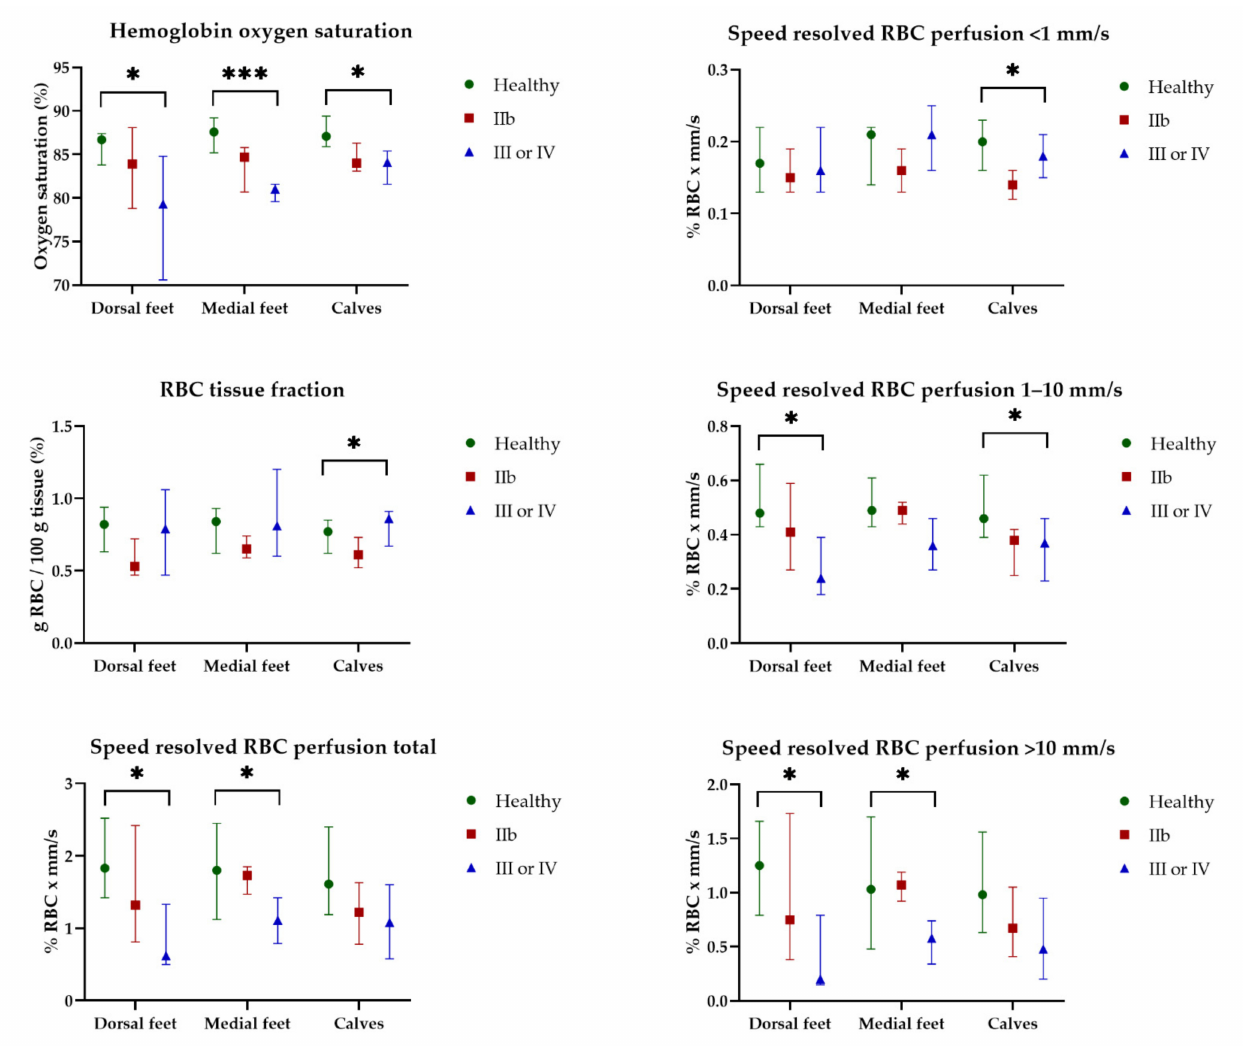
Figure 6. Continuous enhanced perfusion and oxygen saturation (EPOS) variables at 44 ◦ C between healthy volunteers (Healthy), patients with Fontaine class IIb (IIb), and patients with Fontaine class III or IV (III or IV) measured on the dorsal side of the foot, medial side of the foot, and the lateral side of the calf. Data are presented as median (interquartile range). Statistical significance: * p < 0.05, *** p <